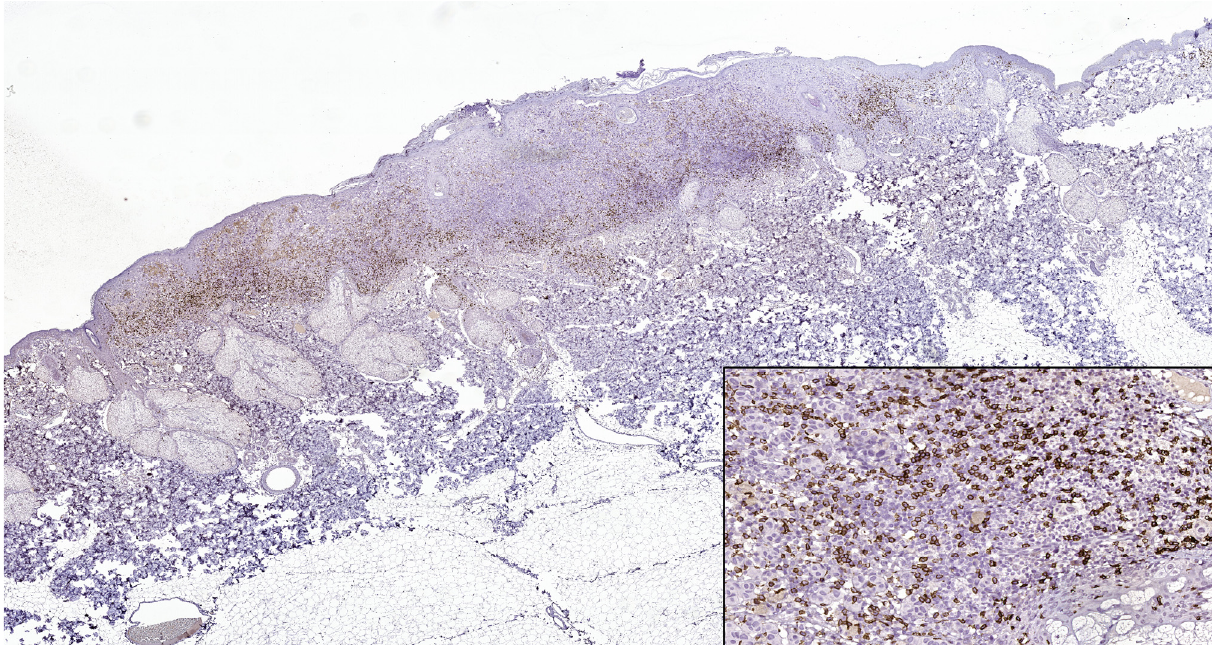
Figure 2. CD8 intense positive reaction in superficial spreading melanoma (CD8 Monoclonal Anti ‐ body, clone SP16, scanned image). In the lower right side, detail ob.x200.